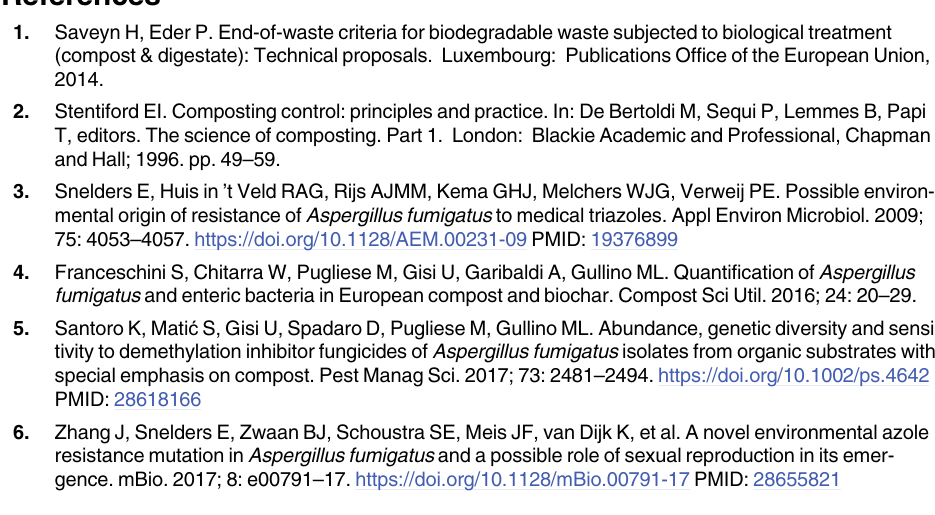
S2 Fig. Phylogenetic relationship of Aspergillus fumigatus isolates from orange-based, green and brown composts, and biochars of different origins: Spanish (S), Hungarian (H), Dutch (NL), British (UK) and Italian (I) isolates based on the cyp51A amino acid sequence inferred by Neighbour-joining analysis. Bootstrap analysis is supported with 1000 replica- tions. The isolate 502.3_24.5 with reduced sensitivity to voriconazole and posaconazole is shown in italics. Cyp51A amino acid sequences are from this study, Francheschini et al. [4], Santoro et al. [5]. Reference resistant isolates are also included and shown in bold: ITZ.86_Rc, Snelders et al. [28]; 11_0087A_Re, Prigitano et al. [31]; 14_Re, Van der Linden et al. [30]; 98 Rc, Van Ingen et al. [32]. Wild-type AF338659 –WT, Mellado et al. [13].